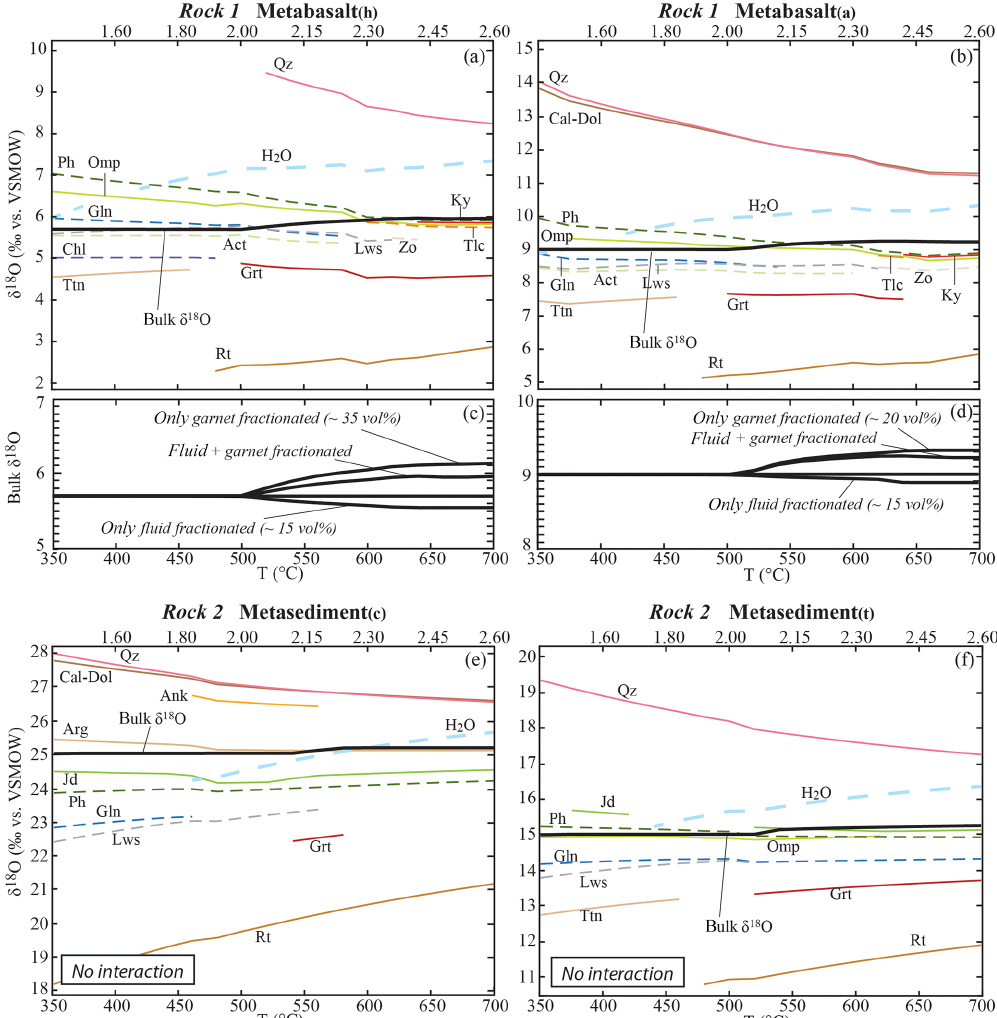
Figure 4. Calculated bulk and mineral δ 18 O values along the geotherm shown in Fig. 2. Bulk δ 18 O: black solid line. Hydrous mineral δ 18 O: coloured dashed lines. Anhydrous mineral δ 18 O: coloured solid lines. Released H 2 O: thick blue dashed lines. (a, b) Modelled mineral, bulk and released fluid δ 18 O values for the metabasalt ( h ) and the metabasalt ( a ) considering garnet fractionation and excess fluid loss and in the absence of external fluid input. (c, d) Quantification of the effects of garnet fractionation and fluid loss on the bulk δ 18 O of the metabasalts. (e, f) Modelled mineral, bulk and released fluid δ 18 O values for the metasediment ( c ) and the metasediment ( t ) considering garnet fractionation and excess fluid loss and in the absence of external fluid input. Scale on the top x axis indicates P (GPa). Mineral abbreviations from Whitney and Evans